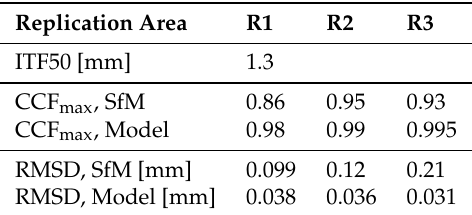
Table 2. Quantitative values for evaluating the SfM reconstruction. CCF max and RMSD are included for all three areas R1 to R3 while ITF50 was only calculated for